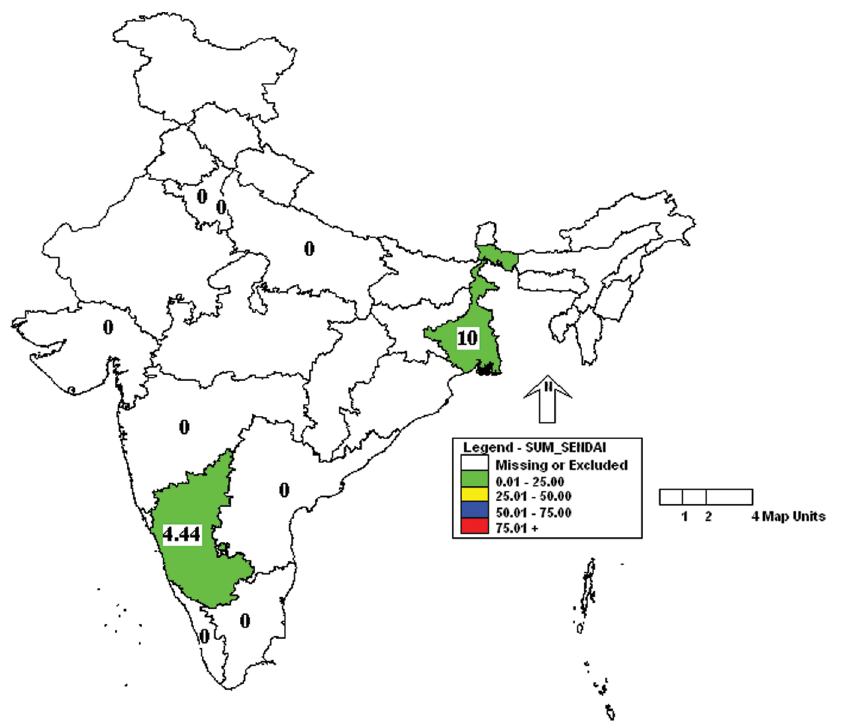
Fig 4. Incidence of Sendai virus (SeV) in different states of India. Green — 00.00 to 25.00%.